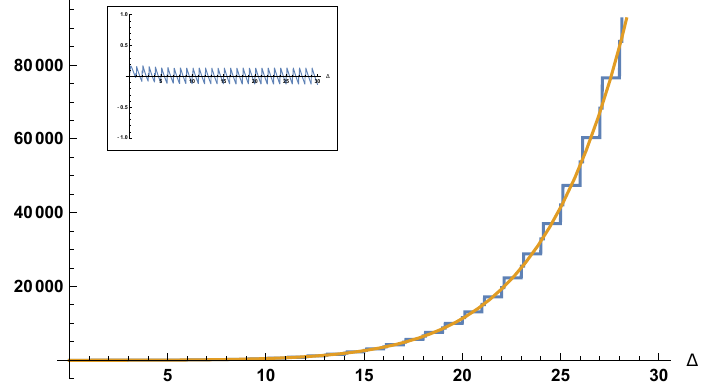
(∆) (orange). To check the error term 0